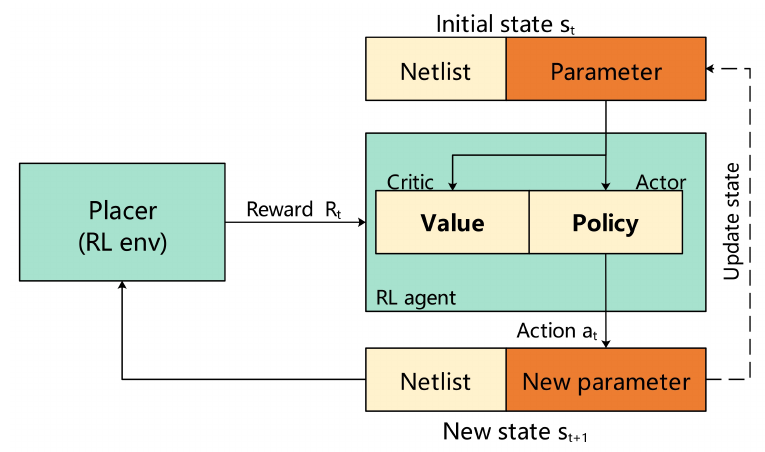
Figure 6. An automatic parameter optimization framework based on RL. The state contains the netlist information and the current parameter set. The agent uses the actor-critic framework to get a new parameter set. The reward is the negative value of the HPWL output from the placement engine